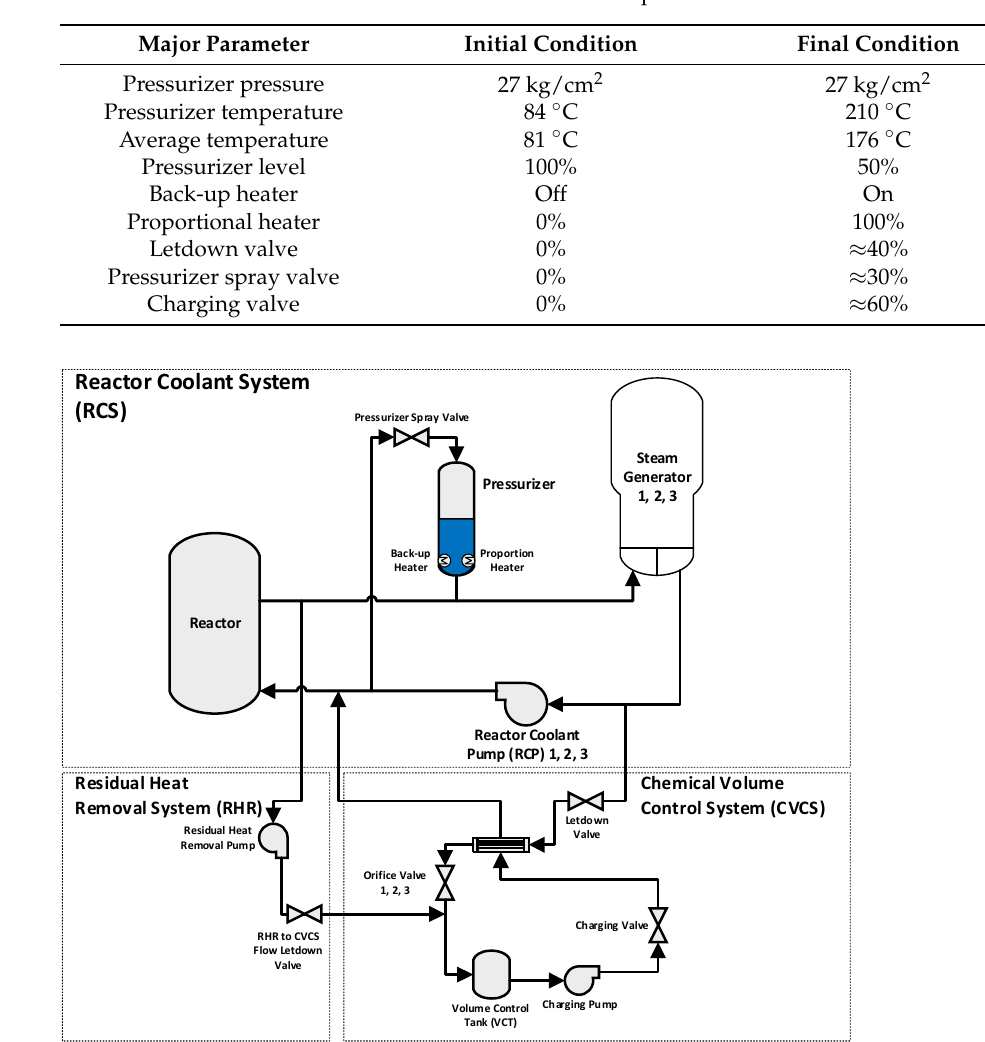
Table 1. Initial and final conditions of the cold shutdown operation.